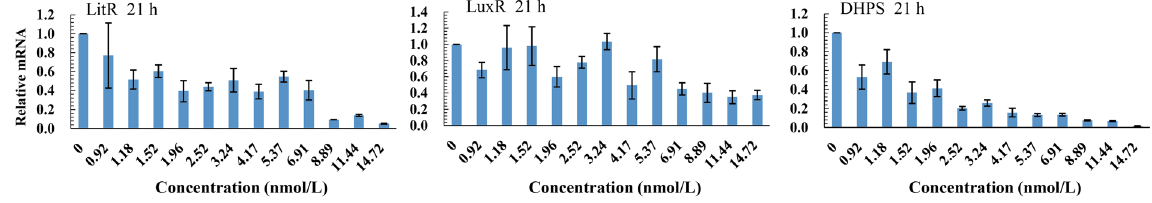
Figure 4. Expression of related proteins in the QS systems of V . fischeri upon exposure to